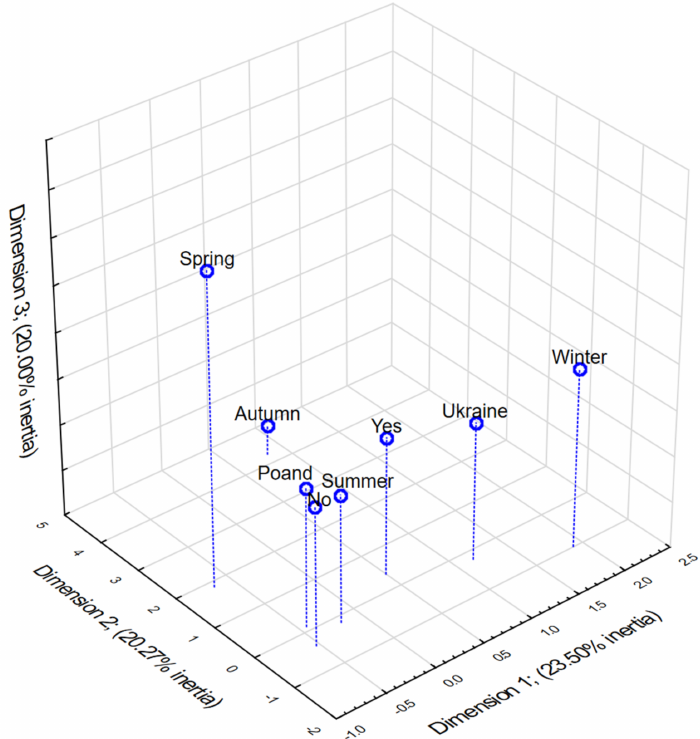
Figure 2. Three-dimensional column coordinate plot for country data, period of use of the largest amount of tap water supplied and use of additional tap water filtration and/or treatment device. Taste of tap water was better rated by consumers in Poland than in Ukraine in spring (M Poland = 3.83; SD Poland = 1.01 and M Ukraine = 2.56; SD Ukraine = 1.22), summer (M Poland = 3.8; SD Poland = 1.03 i M Ukraine = 2.56; SD Ukraine = 1.27), autumn (M Poland = 3.78; SD Poland = 1.04 and M Ukraine = 2.62; SD Ukraine = 1.21) and in winter (M Poland = 3.78; SD Poland = 1.11 and M Ukraine = 2.64; SD Ukraine = 1.28). On the basis of Mann–Whitney U-test results, it was found that the above differences were statistically significant, which means that tap water supplied in Poland had significantly better taste than that supplied in Ukraine in spring: Z = 17.57; p < 0.001; r g = 0.56; summer: Z = 16.72; p < 0.001; r g = 0.53; autumn: Z = 16.31; p < 0.001; r g = 0.52; and in winter: Z = 15.25; p < 0.001; r g = 0.48 (Table 8, Figure 3).